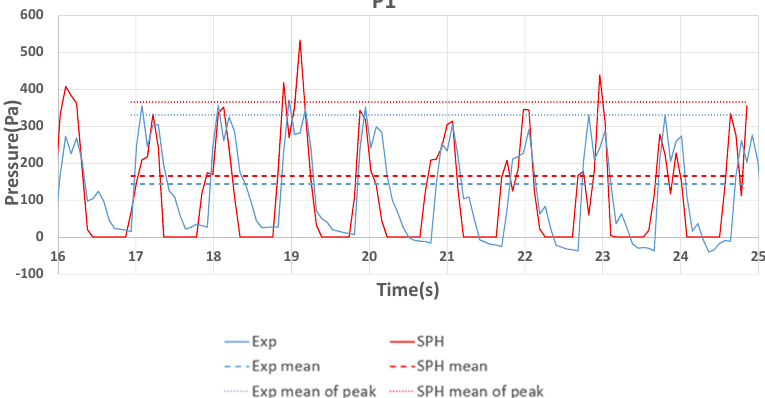
Figure 10. Impact pressure under roll excitation with a particle spacing 0.8 mm at a 25% filling ratio.